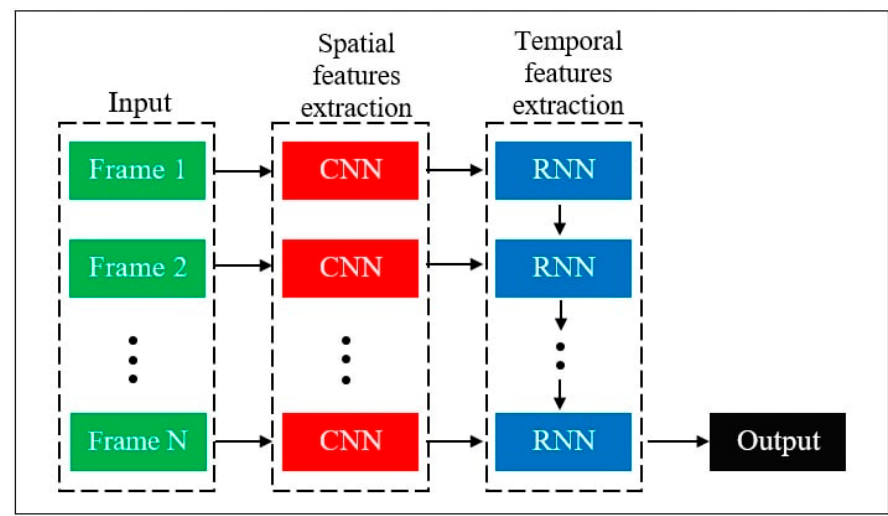
Figure 5 . The combined CNN-RNN architecture . Figure 5. The combined CNN-RNN architecture.